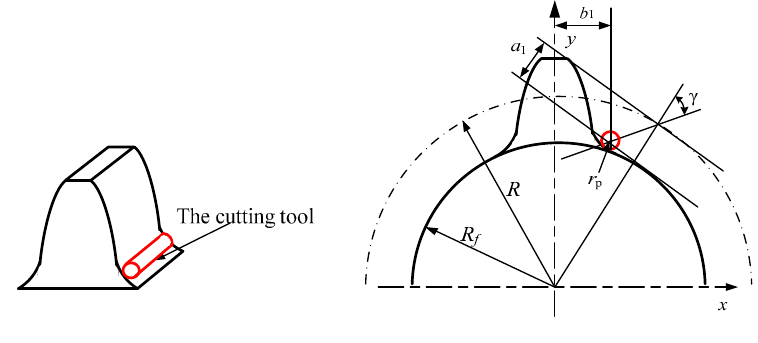
Figure 3. Root guide angle circle trajectory.